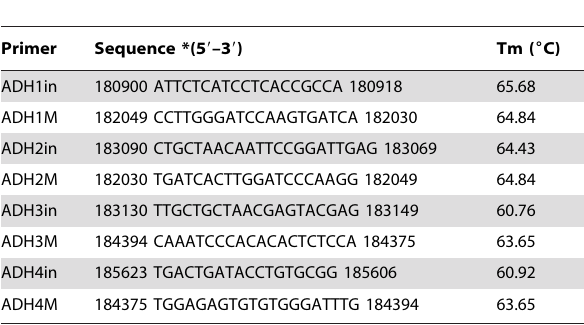
Table 1. Primers used in P1-RFLP gene typing.